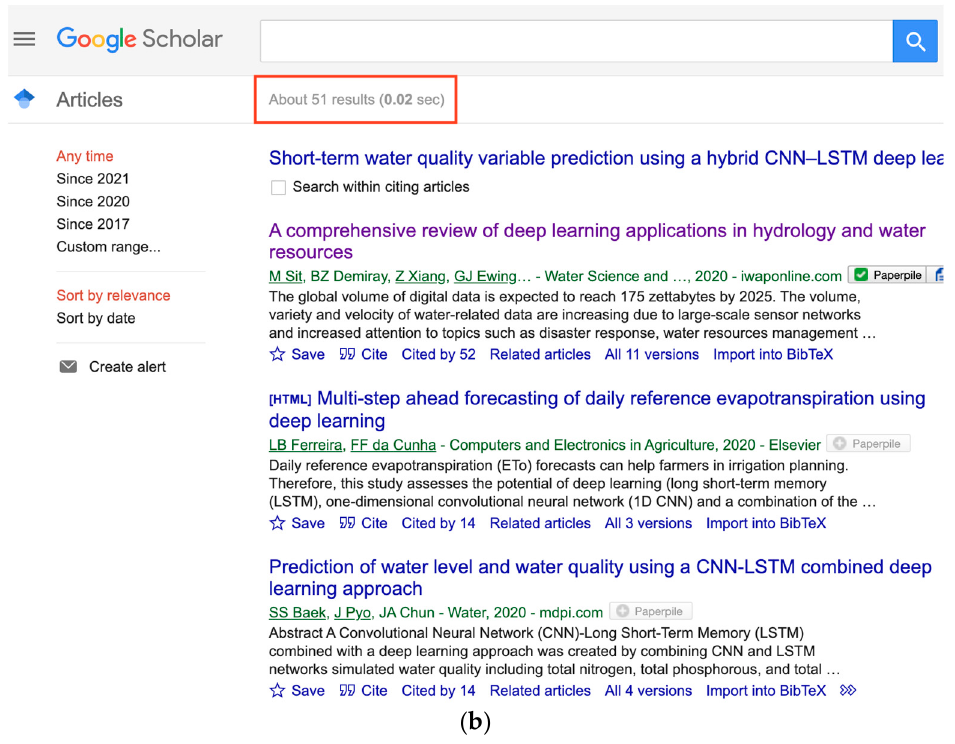
Figure A1. Our highly interactive web app (accessible publicly at: https://geoair-lab.github.io/WaterFeatureAI-WebApp/index.html, accessed on 5 December 2021) provides the track of scholars and publications with just a few clicks. See an example on the pop-up. Our readers can access (1) a direct link to the PDF file of the paper (note that if there is no free, publicly available version of the paper, we link directly to the journal page of the paper so our readers can obtain the paper if their institution purchases the journal database), (2) the scholar profile (Google Scholar/ResearchGate URL) of the first author, and (3) “Cited by” Google Scholar page. ( a ) Water body and quality AI literature map pop-up. ( b ) “Cited by” Google Scholar page corresponding to the paper shown in ( a ).